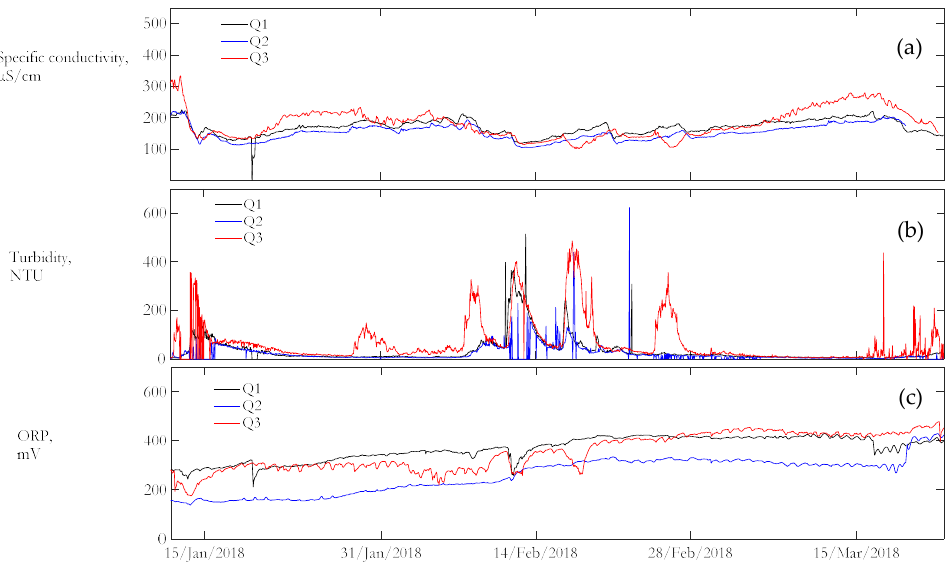
Figure 8. Sensor measurements of ( a ) specific conductance, ( b ) turbidity and ( c ) oxidation–reduction potential (ORP) at three locations (Q1, Q2 and Q3) of the Kanawha River.